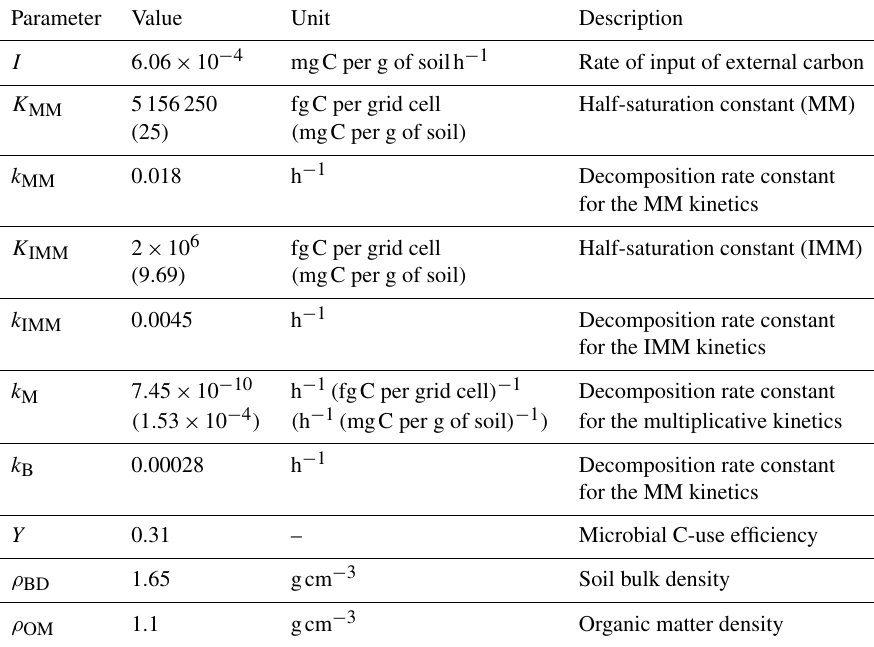
Table A1. List of parameters. Values in brackets correspond to the units reported in brackets.